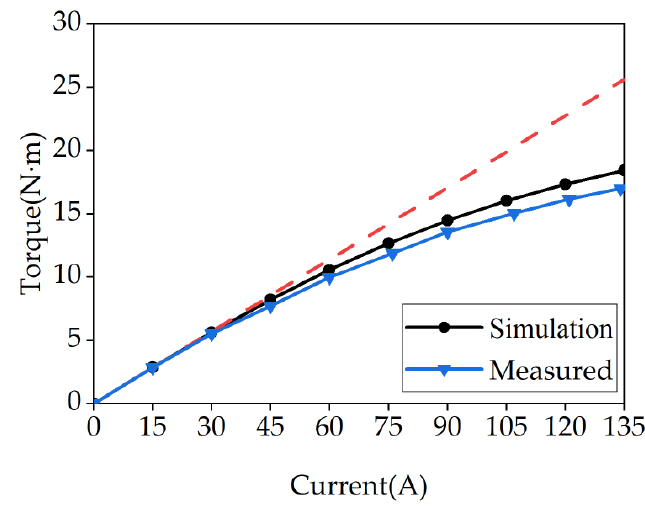
Figure 14. The contrast of T-I curves.